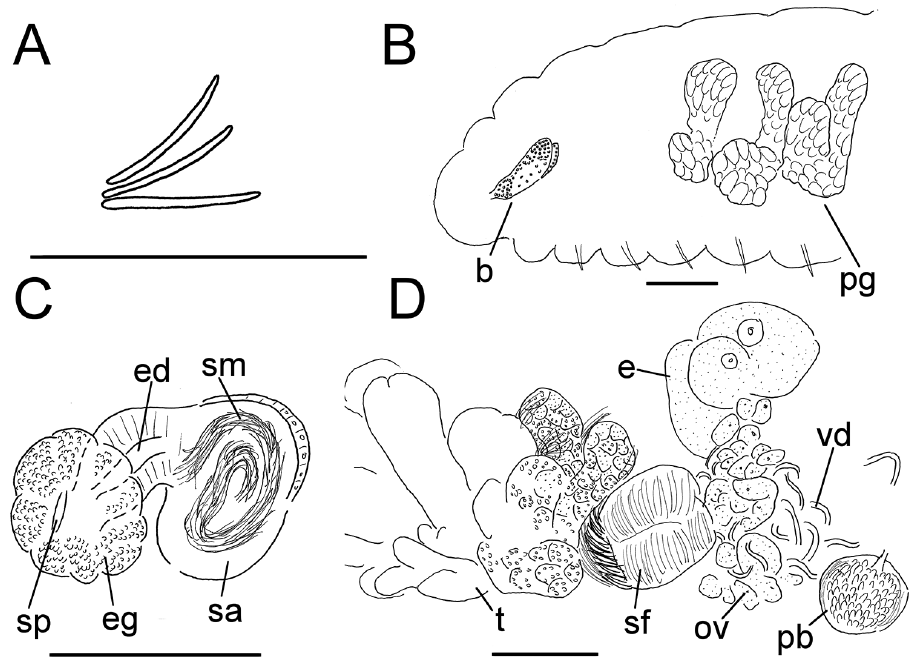
Figure 16. Lumbricillus tuba . A Chaetal bundle B Anterior body C Spermatheca D Other genitalia. Abbreviations under general notes. Scale bars: 100